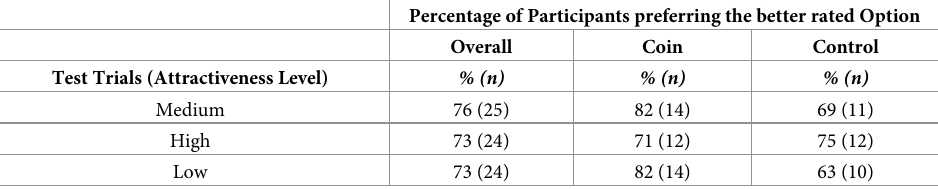
Table 2. Percentage of preference alignment in the pilot study.